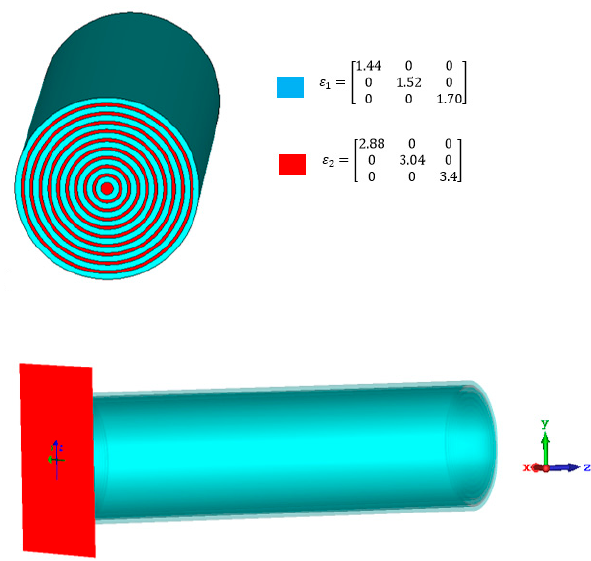
Figure 1. Structural configuration of dielectric tensors and excitation used for CST (Computer Simulation Technology) analysis.